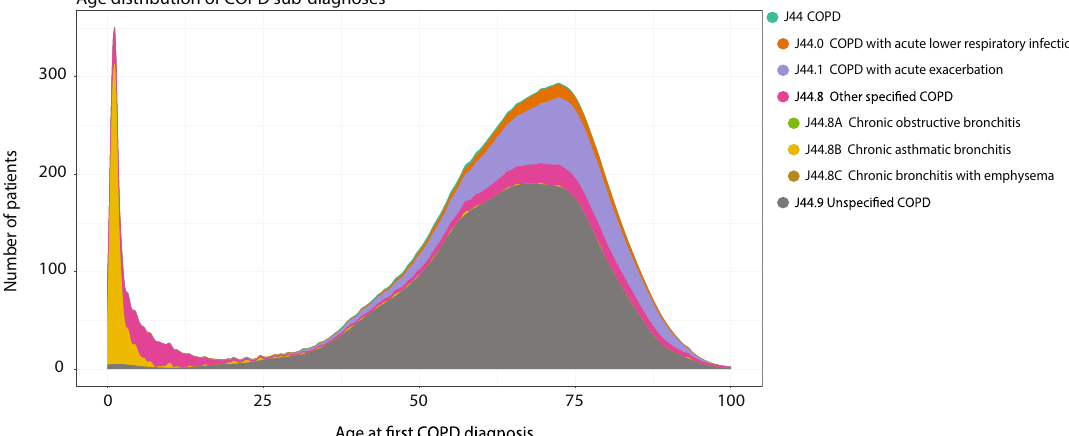
Fig. 3 Age distribution of chronic obstructive pulmonary disease (COPD) sub-diagnoses. Age distribution of sub-diagnoses of the COPD diagnosis for the most dissimilar patients. The colours correspond to different four- or fi ve-character subcategories in the registry. The fi rst peak in diagnoses occur in early childhood and mainly consists of “ Other Chronic Obstructive Pulmonary Disease ” (J44.8) and especially “ Chronic asthmatic bronchitis ” (J44.8B), which is typically diagnosed in children. In general, the majority of the patients are diagnosed with “ Unspeci fi ed COPD ”